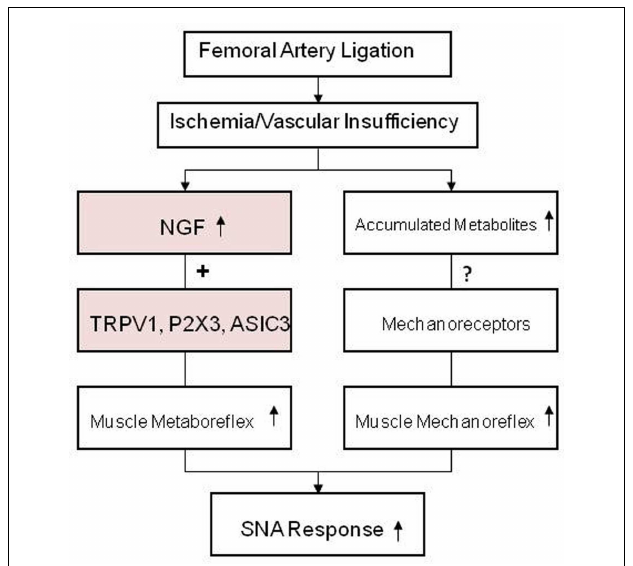
FIGURE 5 |The schematic diagram summarizes the regulatory mechanisms of the exaggerated sympathetic response to activation of the muscle metabo- and mechano-sensitive afferent nerves after femoral artery